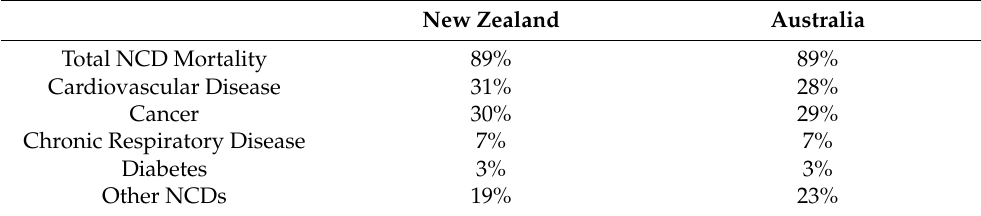
Table 1. NZ vs. AUS NCD’s 2018. Adapted from the WHO NCD Country profiles of 2018